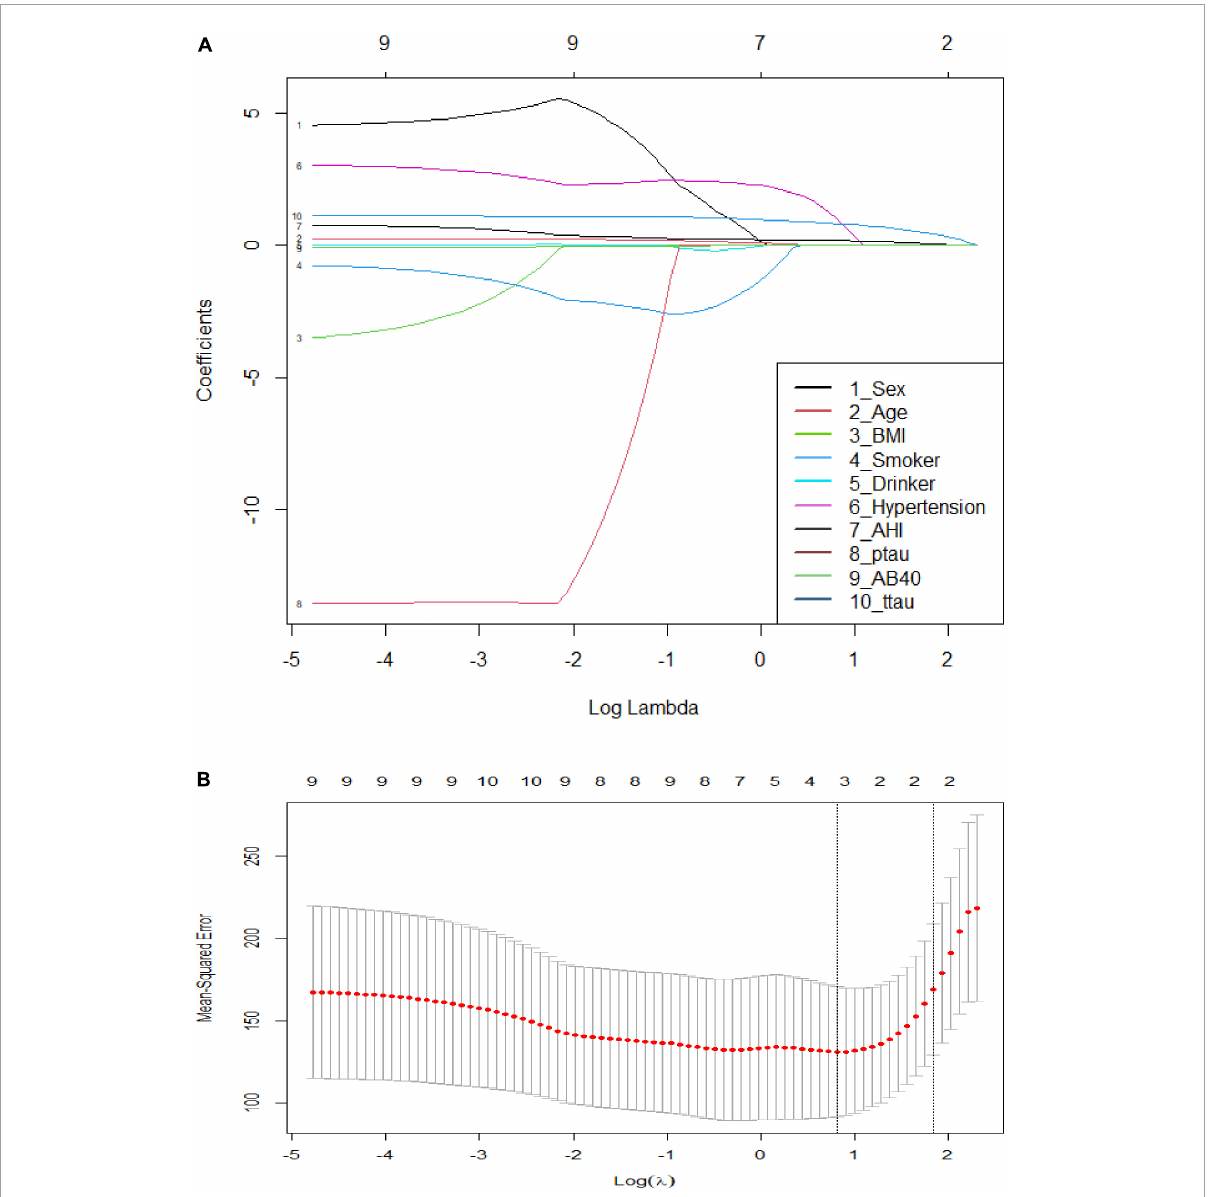
FIGURE5 Visualized results and cross-validation of lasso regression. (A) Least absolute shrinkage and selection operator coefficient profiles; (B) Partial likelihood deviance for LASSO coefficient profiles. The red dots represent the partial likelihood values, the gray lines represent the standard error (SE), and the vertical dotted line is shown at the optimal values by